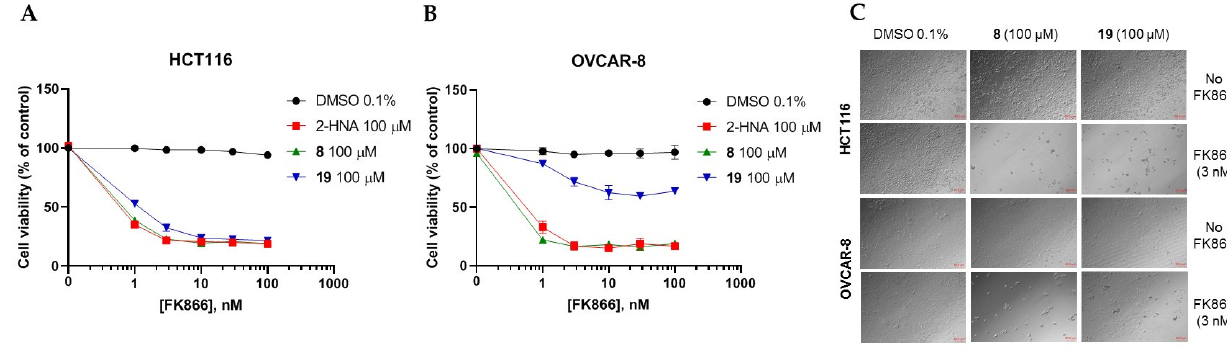
Figure 6. Compound 8 and compound 19 sensitize ovarian and colon cancer cells to FK866 via NAPRT inhibition. ( A–F ) HCT116 and OVCAR-8 were plated in 96-well plates (2x10 3 cells/well) and allowed to adhere overnight. The following day, culture media were replaced with new media containing the respective treatments (i.e., with or without FK866 at increasing concentrations from 1 to 100 nM and the putative NAPRT inhibitors, added at 100 μ M final concentration), and the plates were then incubated for 72 h. Afterwards, the cells were imaged using light microscopy as in ( C ), and cell viability was determined using the sulforhodamine B assay. Data are mean ± SD of three experimental replicates. ( G ) and ( H ) The same experimental procedure was employed as in ( A–F ). Single concentrations of the NAPRT inhibitors (100 µM), 100 nM FK866, 10 µM NA, and 10 µM NAMN were added. Data are mean ± SD of 4 experimental replicates. One representative experiment is shown. *, p < 0.05 ; ***, p < 0.001 ; ****, p < 0.0001 ; $$$$, p < 0.0001. The * symbols refer to the statistical significance compared to the treatment with FK866 alone, whereas the $ symbols refer to the statistical significance compared to the combined treatment with FK866 and the NAPRT inhibitors. 2.2.2. Biochemical Activity on Recombinant Human NAPRT Given these results in cancer cells, we evaluated the activity of our candidates on the recombinant human NAPRT protein. If the NAPRT enzyme is efficiently inhibited by our compounds, it is postulated to consume less NA compared to what is observed in the absence of NAPRT inhibitors. As expected, the chromatographic analysis revealed higher NA and lower NAMN amounts when compounds 1 , 2 , 8, and 19 were added to the reaction mixture, in line with their on-target inhibitory activity (data not shown). We